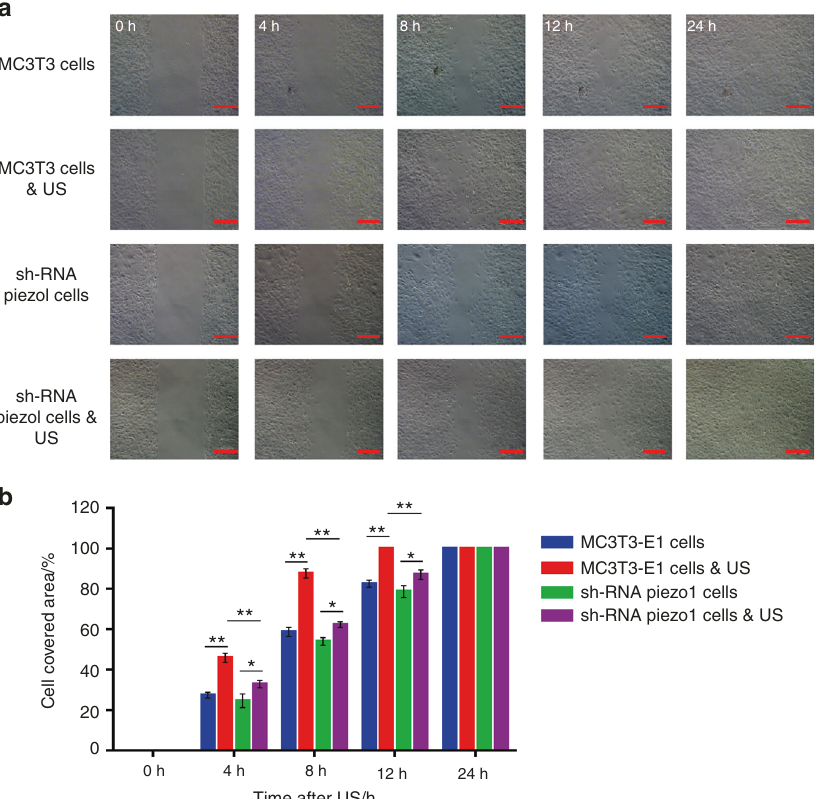
Fig. 2 Wound healing and migration assay. a Randomly selected images of the gap (500 μ m) at 0, 4, 8, 12, and 24 h after treatment with or without LIPUS stimulation. Scale bars, 200 μ m. b Changes in the cell-covered area over time. LIPUS stimulation signi fi cantly increased the migration and proliferation of MC3T3-E1 cells ( n = 3, ** P < 0.01, Student ’ s t -test). LIPUS stimulation also increased the migration and proliferation of shRNA-Piezo1 cells ( n = 3, * P < 0.05, Student ’ s t -test), but the difference was not as obvious as it was in MC3T3-E1 cells. The cell-covered area of MC3T3-E1 cells was signi fi cantly higher than that of shRNA-Piezo1 cells at 4, 8, and 12 h after LIPUS stimulation ( n = 3, ** P < 0.01, Student ’ s t